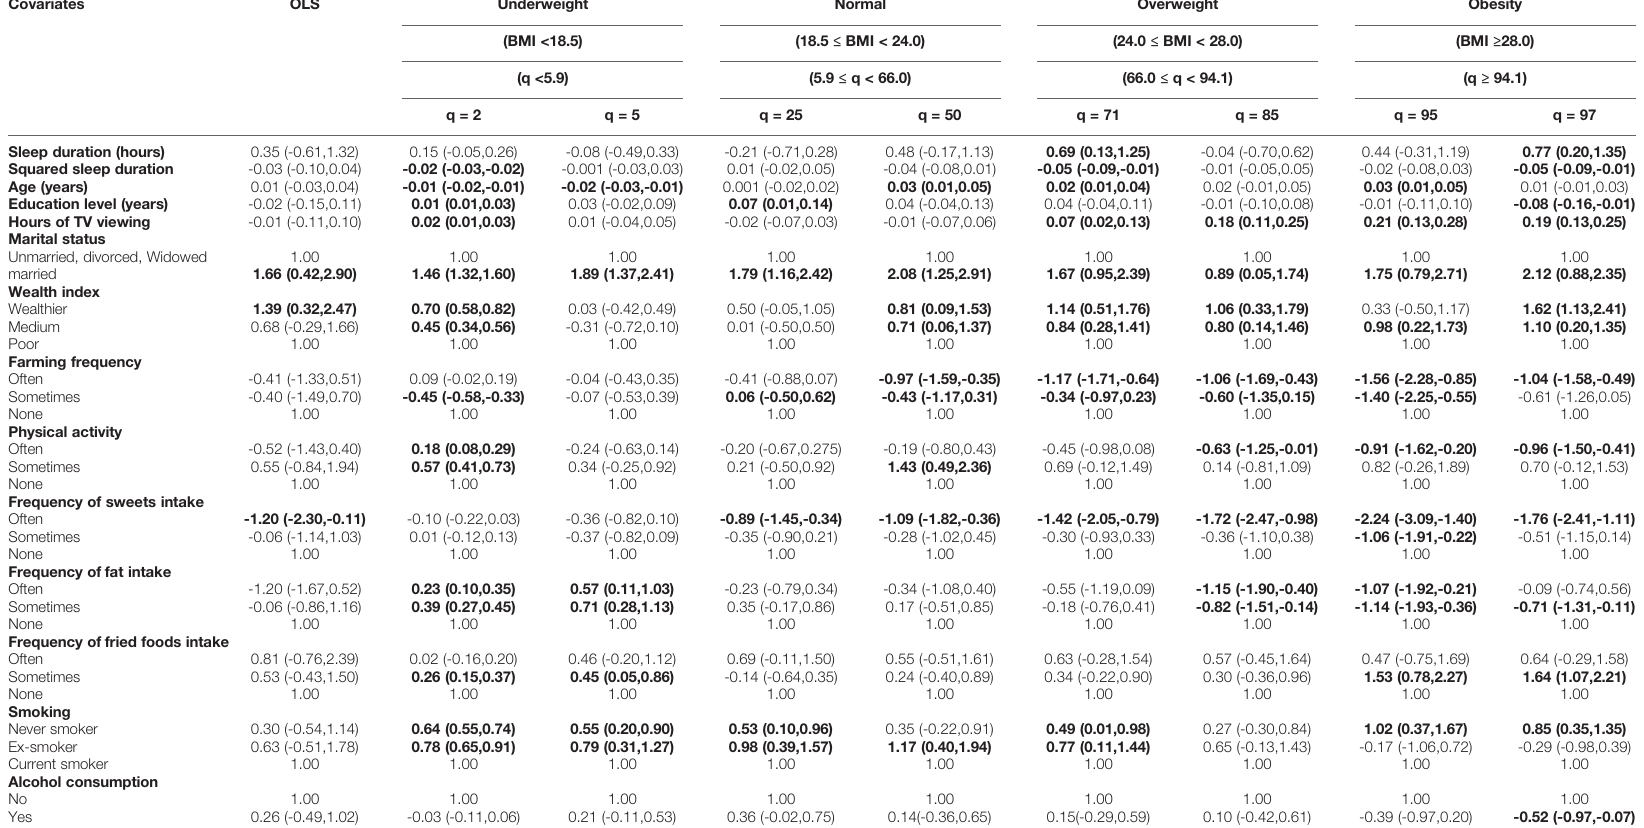
TABLE 2 | The association between sleep duration and the percentiles of BMI among male participants a,b . Covariates OLS Underweight Normal